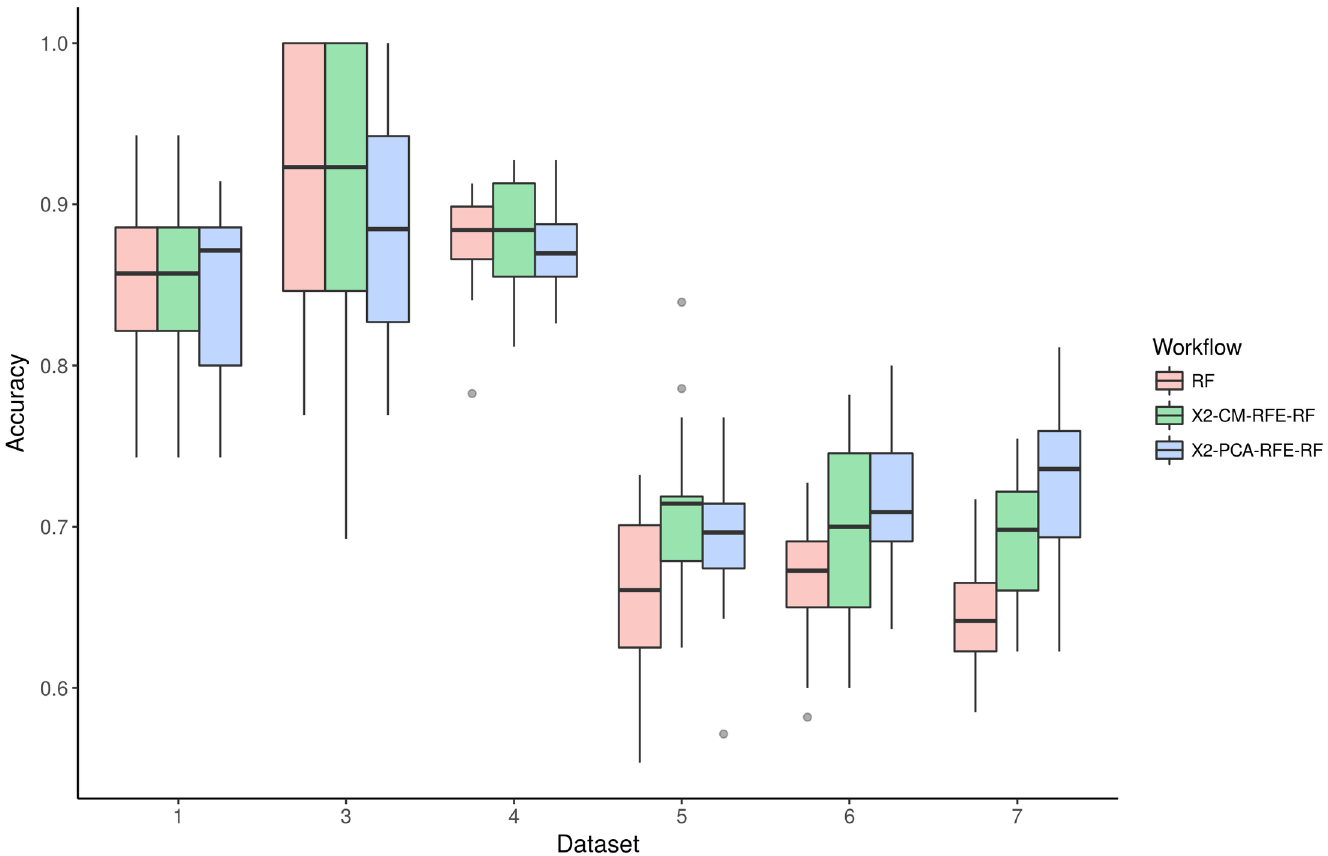
Fig 5. Accuracy vs. feature selection combination for expressiondatasets(1, 3, 4, 5, 6 and 7). ( RF ) RandomForest without previous feature selectionstep; ( X2-CM-RFE-RF ), random forest classificationafter the feature selectionstep using univariatecorrelationfilter with matrix correlationand recursivefeature elimination; ( X2-PCA-RFE-RF ), random forest classificationafter the feature selectionstep using univariatecorrelationfilter with principalcomponentanalysisand recursive feature elimination.All methods includean internalcross-validation 10-fold step. All accuracymetrics were estimated followingthe approach previouslyreportedby Pochet et al . [31], where 20-fold randomized test data were used to summarize the accuracyof the FS combination.